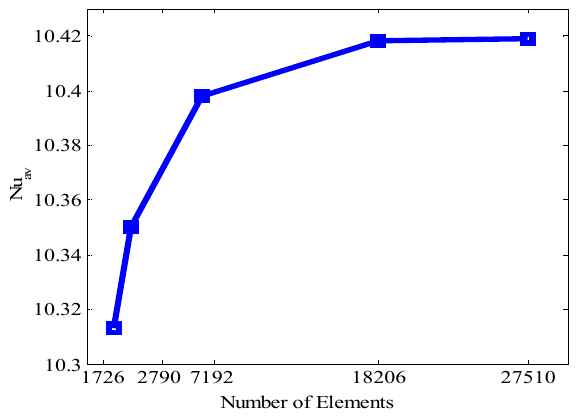
Figure 2. Grid sensitivity test.